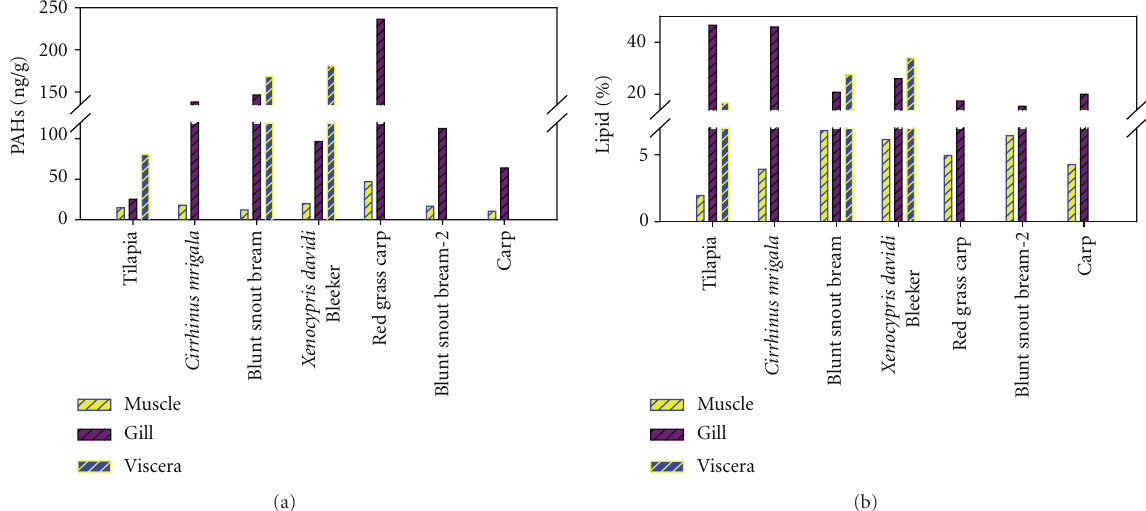
Figure 6: Distribution of total PAHs and lipid (%) in fish species from the Pearl River